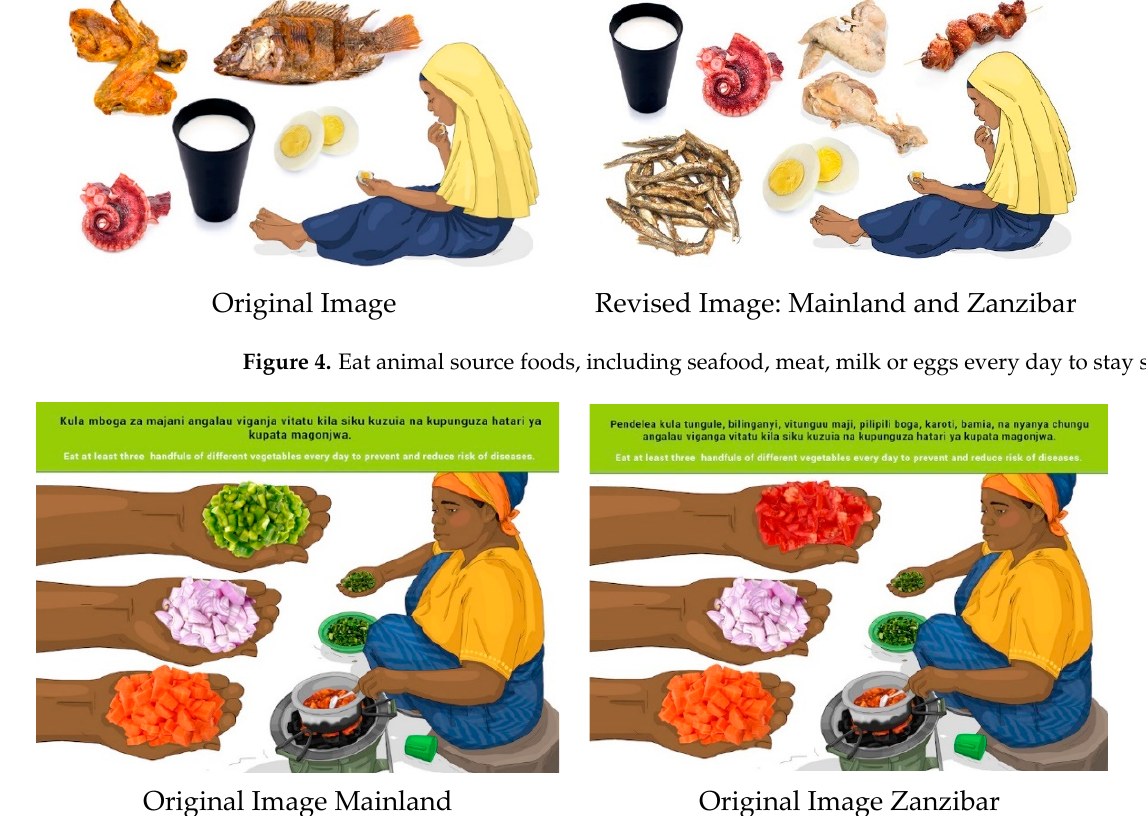
Figure 4. Eat animal source foods, including seafood, meat, milk or eggs every day to stay strong.